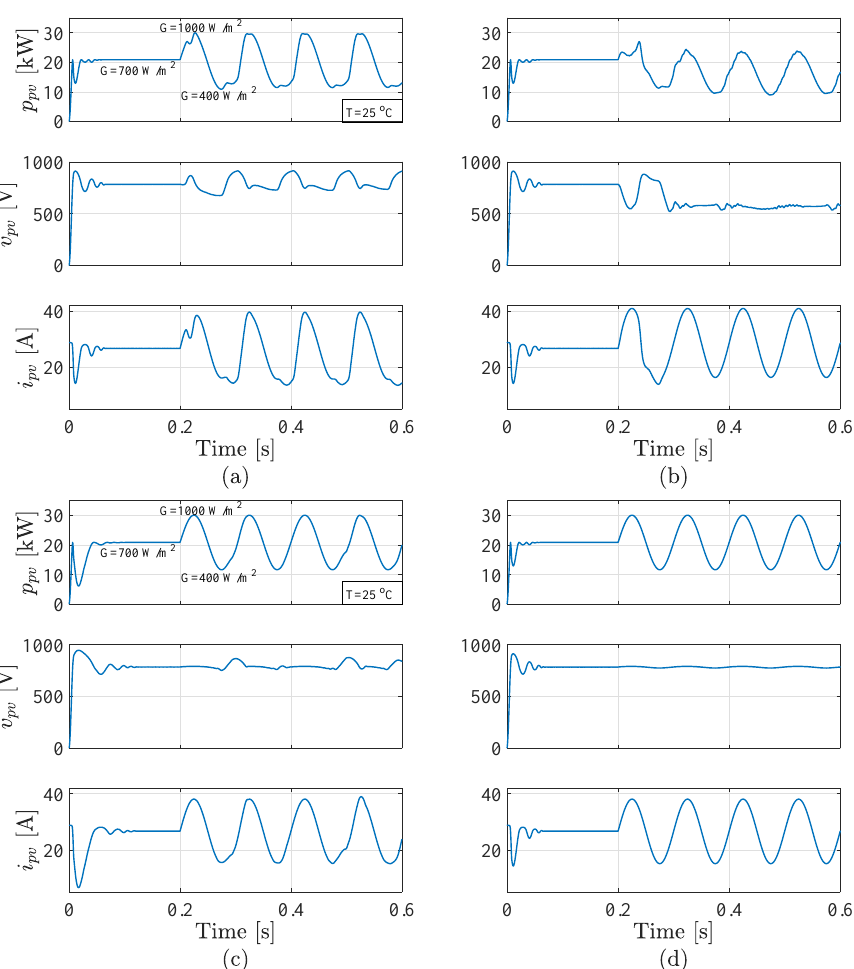
Figure 17. MPPT performance with sinusoidal radiation change: ( a ) P&O method; ( b ) modified P&O; ( c ) multi-power-sample method; ( d ) the proposed model-based technique.